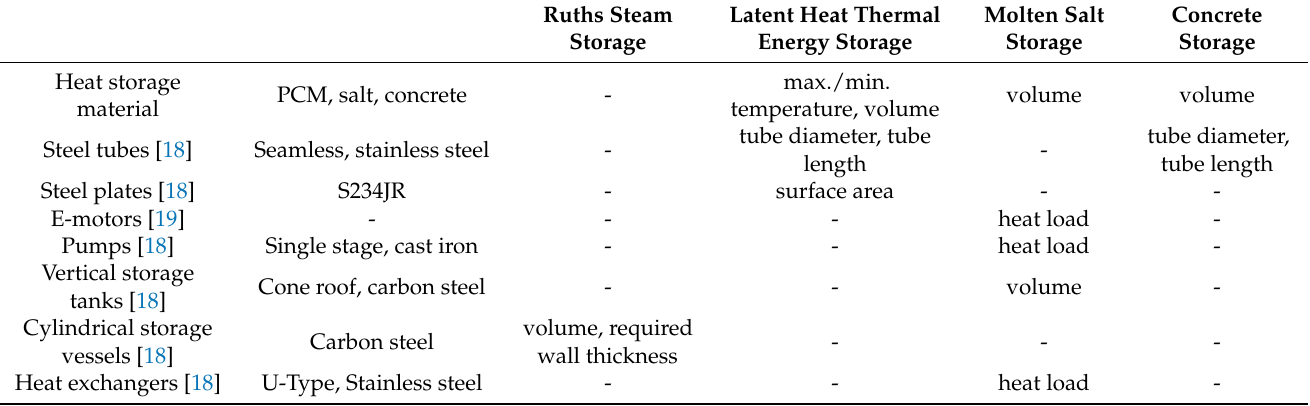
Table 1. Components and key variables that impact the respective component costs for the selected thermal energy storage (TES)